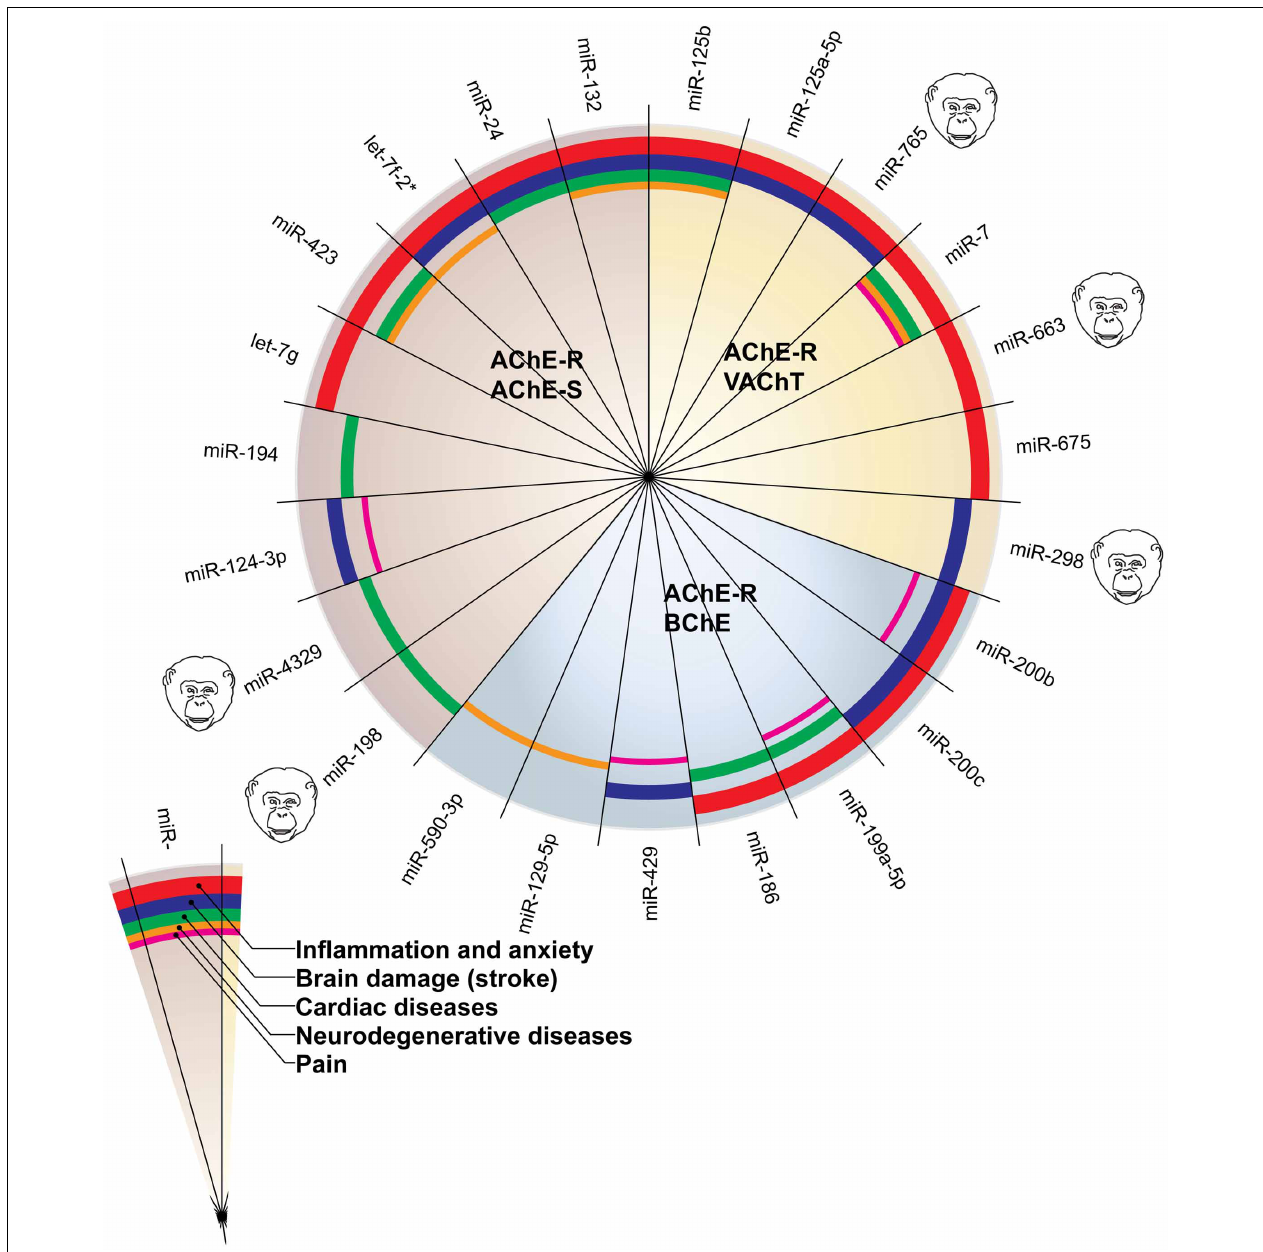
FIGURE 2 | MiRNAs targeting AChE-S and AChE-R, BChE and AChE-R or VAChT and AChE-R show associations to different disease groups related to cholinergic signaling. The pie chart classifies the shared targets, as well as the relevant diseases and highlights the observed interactions between them. Disease group association is shown as surrounding lines of differential thicknesses, reflecting the number of miRNAs in each group. The